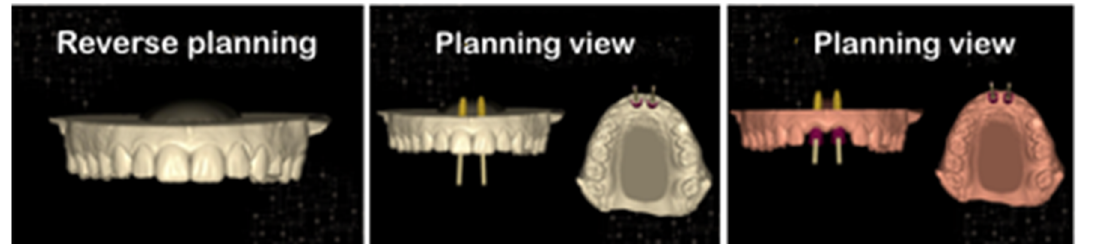
Figure 5. Reverse planning, evaluating implant positioning, and provisional design via DSD program.